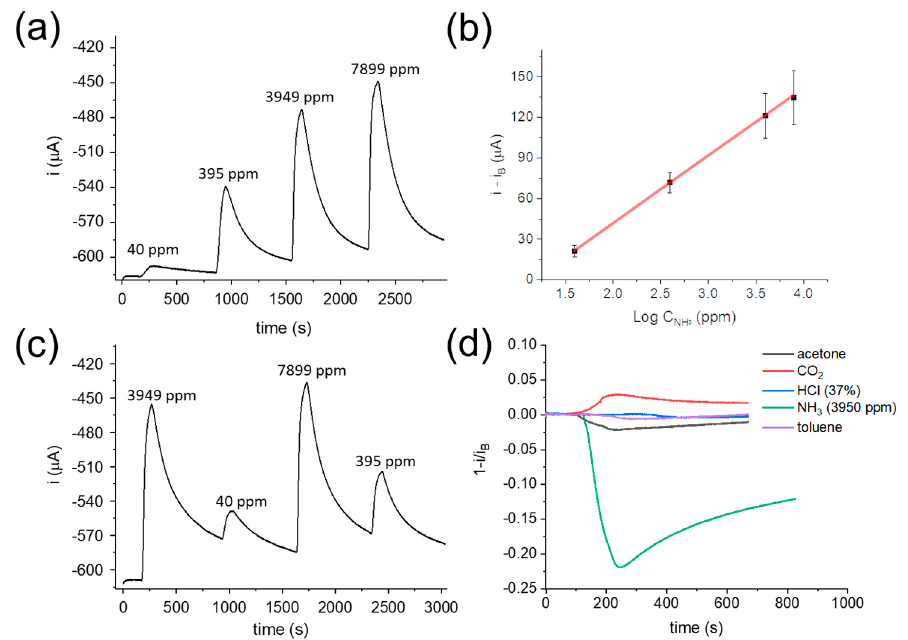
Figure 5. ( a ) Current vs. time response of the NH 3 sensor and ( b ) calibration curve (R 2 = 0.999) obtained from three repeated measurements performed without waiting for baseline recovery. NH 3 - rich air streams were delivered for 100 s and alternated to air flow for 600 s. Flow rate 2 L min –1 ; V app = –200 mV. ( c ) Sensor response recorded upon exposure to random NH 3 concentrations. ( d ) Sensor response recorded upon exposure to common gaseous compounds.